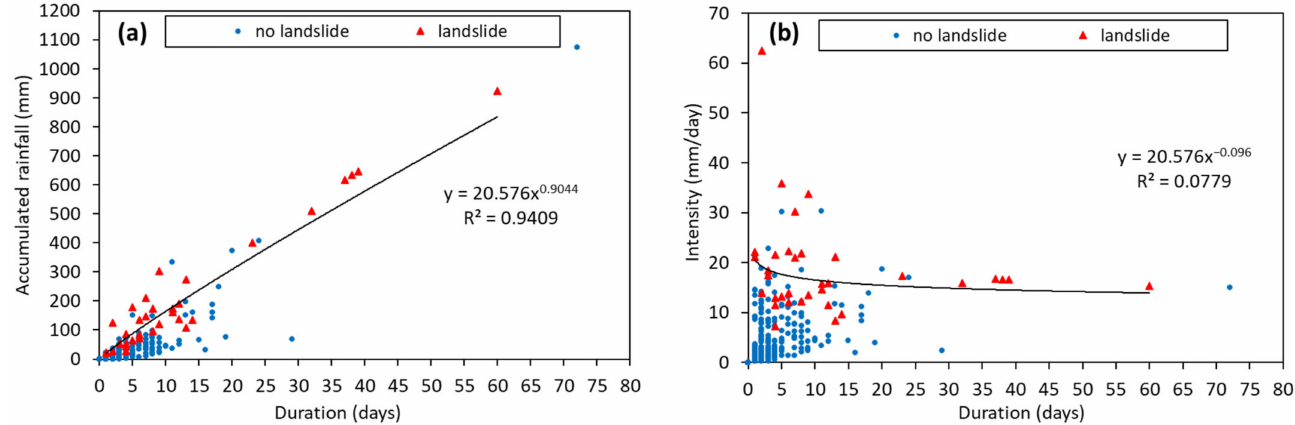
Figure 7. ( a ) Rainfall threshold ED and ( b ) rainfall threshold ID from daily rainfall data for the municipality of Jaboat ã o dos Guararapes. Blue dots represent rains that did not cause landslides, and red dots represent rains related to